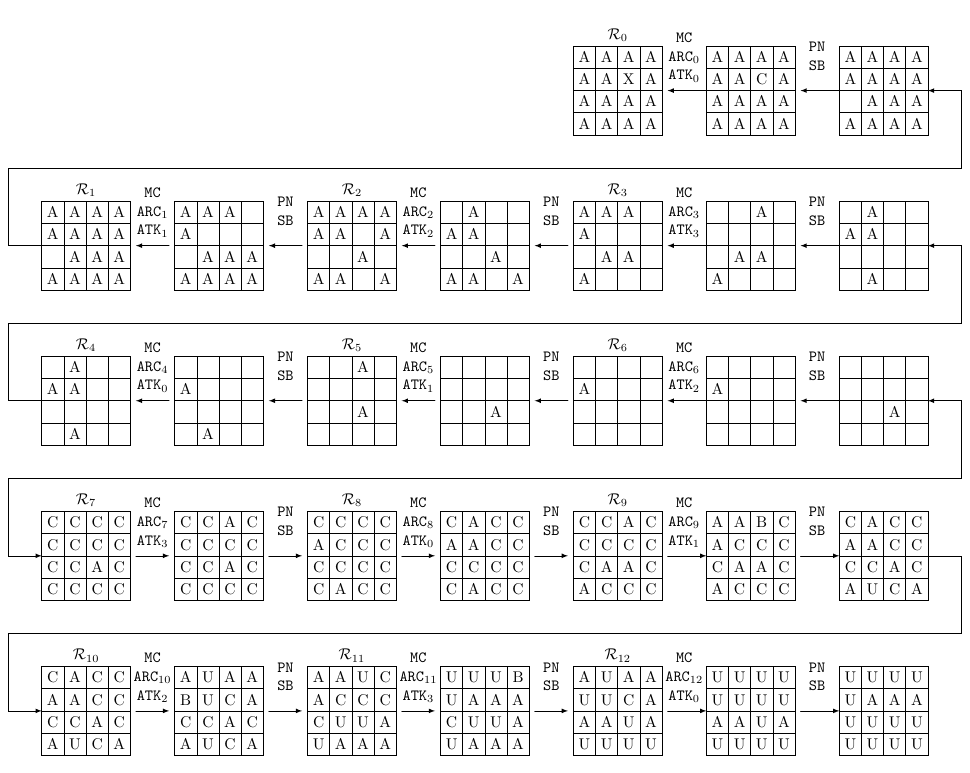
Figure 7: A 13-round integral distinguisher for CRAFT